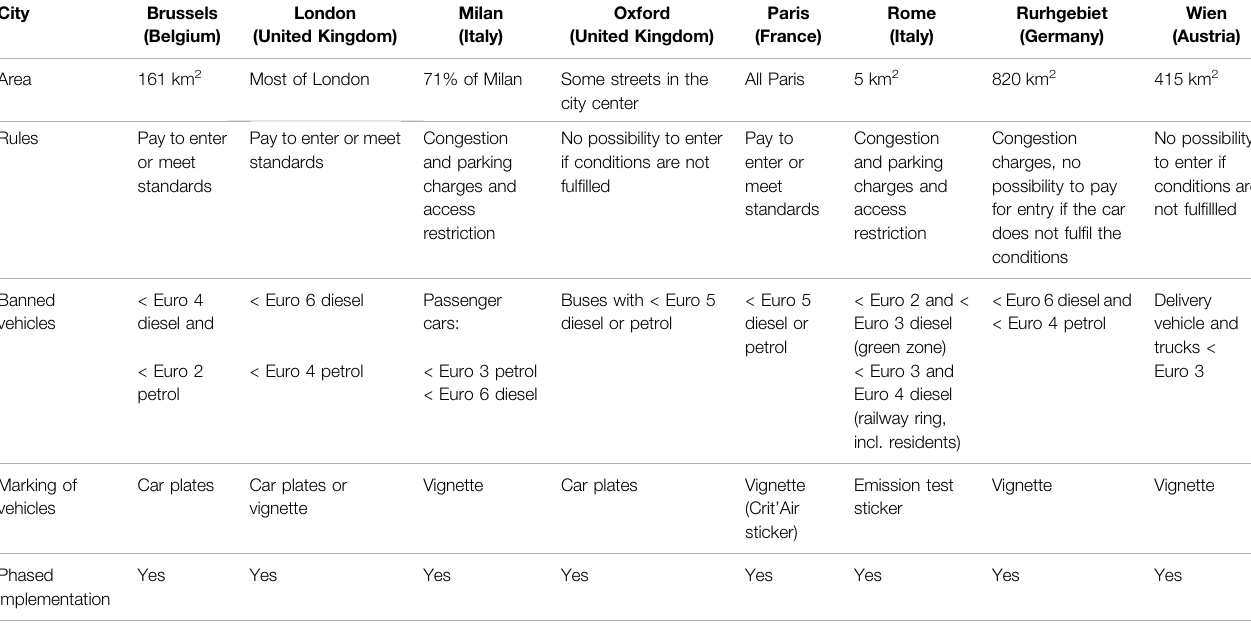
TABLE 1 | Comparison of low emission zones in chosen European